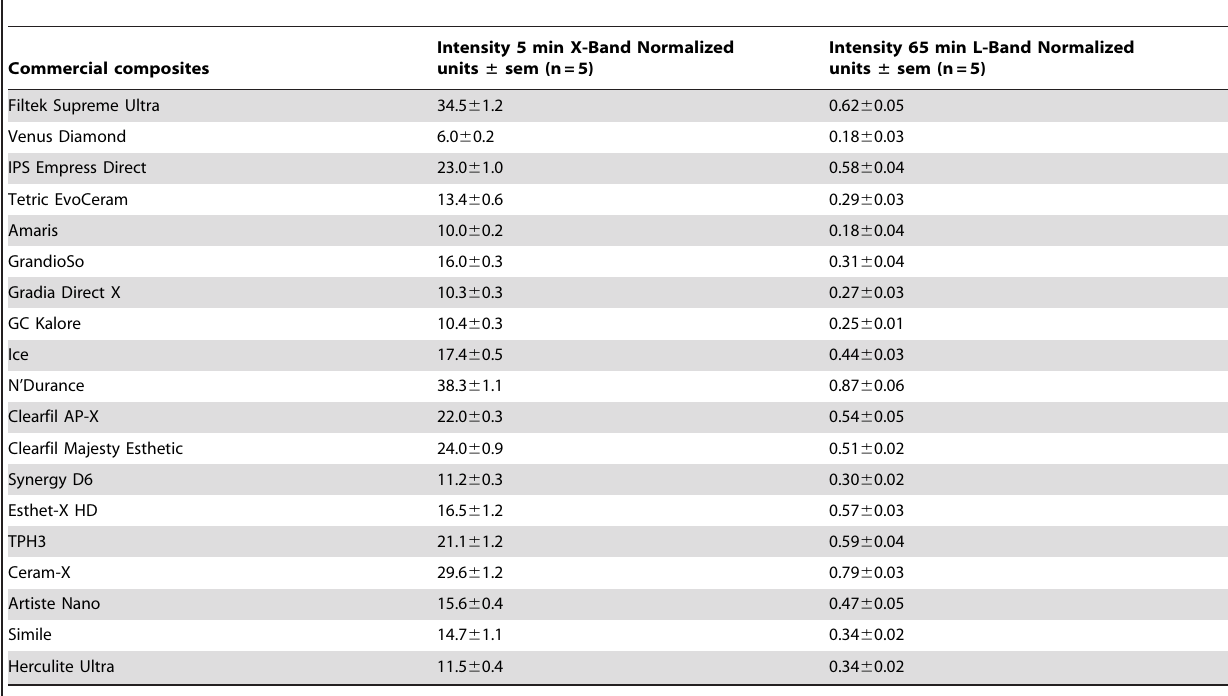
Table 3. Normalized intensities of EPR signal recorded in commercial resins 5 minutes after polymerization (X-band), and 65 minutes after polymerization (L-band).